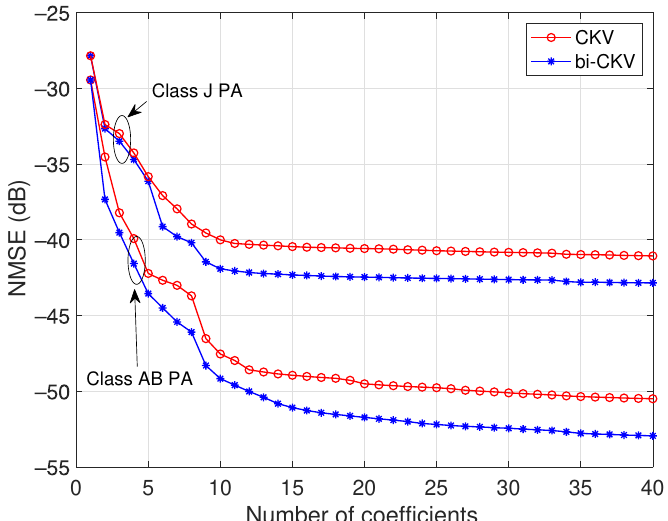
Figure 7. NMSE results of the CKV and the bi-CKV models, for a class AB PA operated at 3.6 GHz with an average output power of 27.4 dBm and a class J PA operated at 850 MHz with an average output power of 26